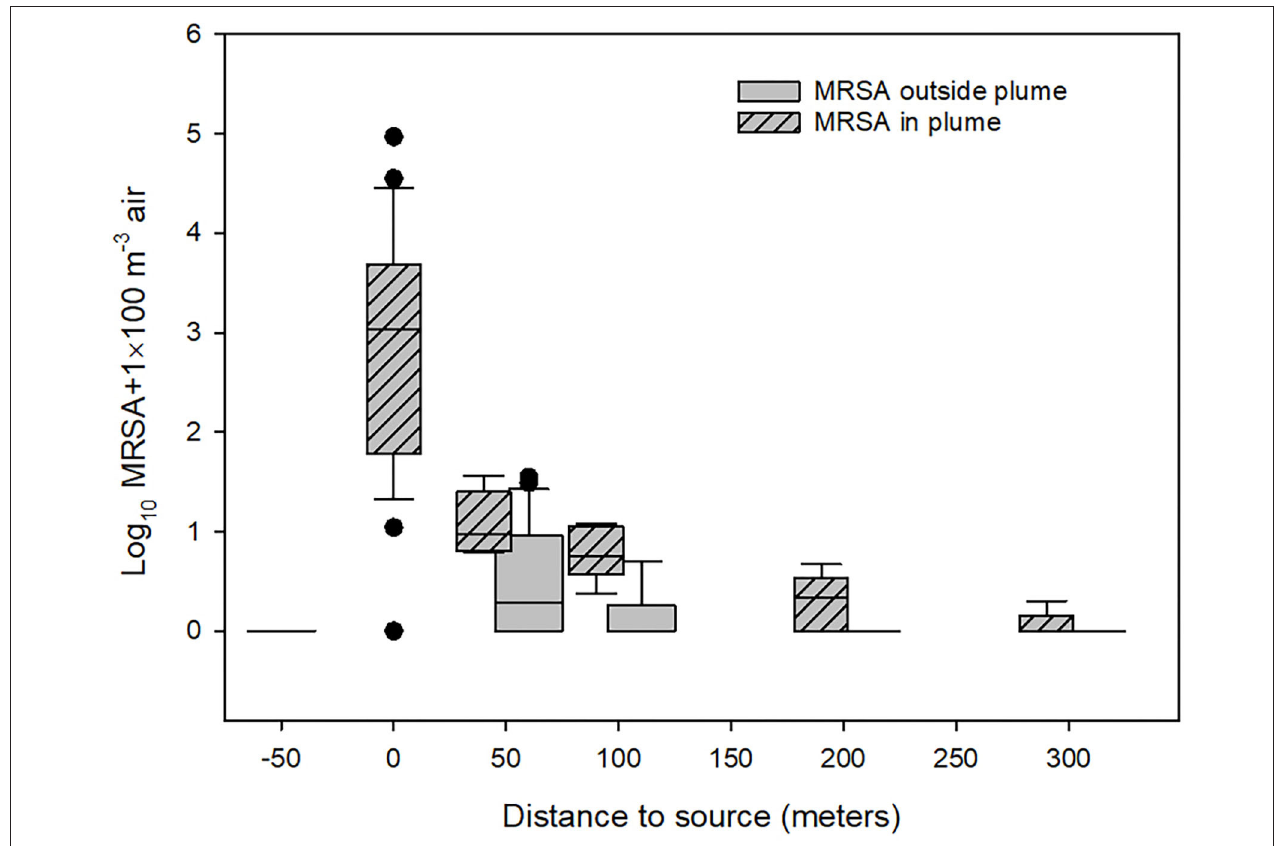
FIGURE 3 | Concentration of LA-MRSA measured outside the swine farm. − 50: Measurements 50 meter upwind from ventilation outlets, 0: measurements from ventilation shafts (not including the measurements from empty stables), 50–300: measurements downwind from the farm. The concentration found in the plume at all distances from the farm was significantly higher than the concentration found outside the plume (Mann-Whitney U-tests; p <